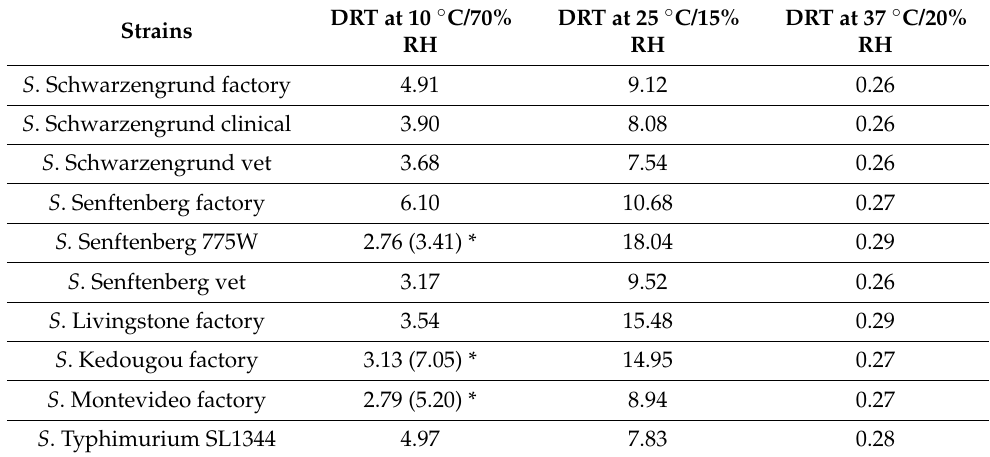
Table 3. Decimal reduction times (days) for Salmonella isolates. DRT at 10 ◦ Strains